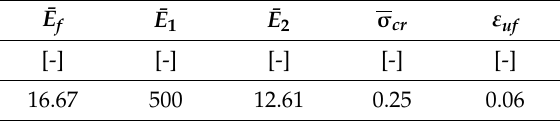
Table 1. Normalized parameters adopted for the analyses.